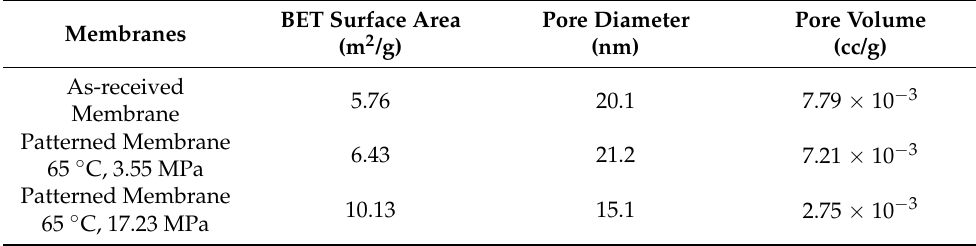
Table 1. Brunauer–Emmet–Teller (BET) analysis data.